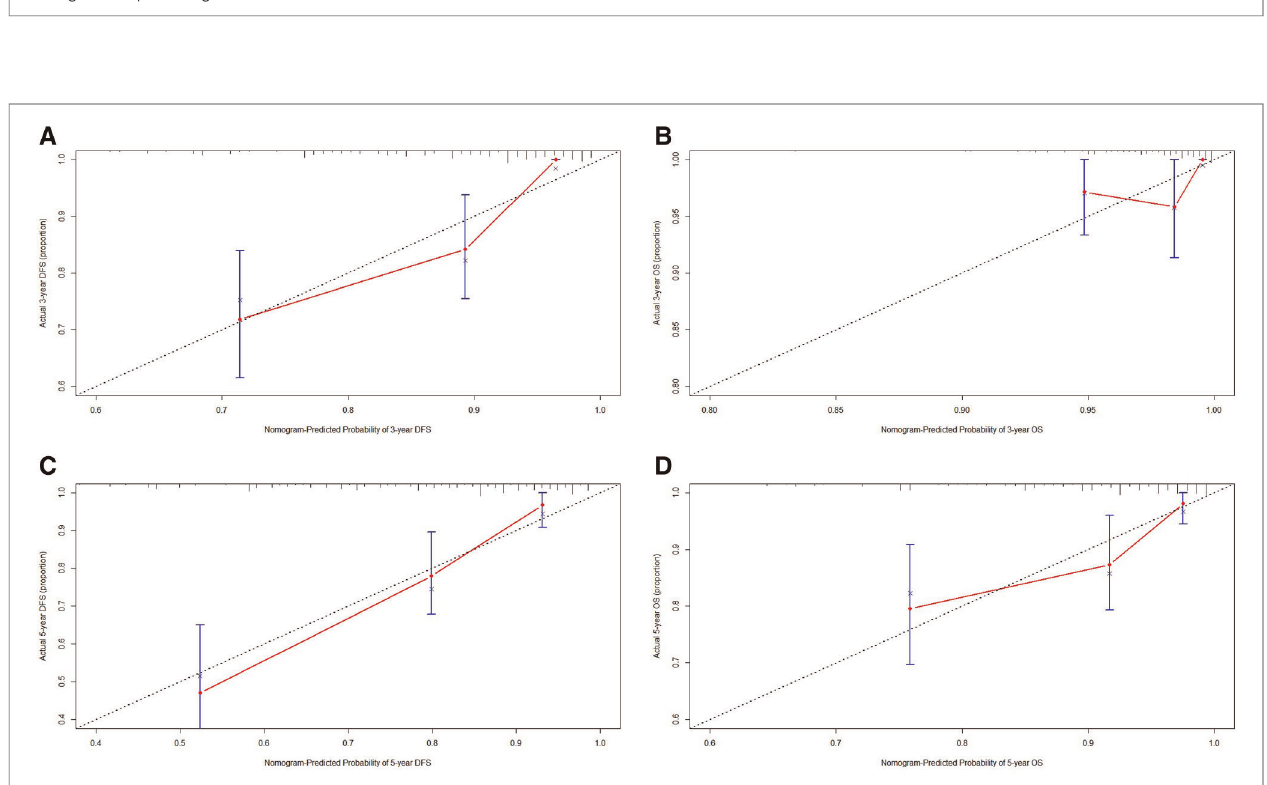
FIGURE 4 | The calibration curves for predicting the 3-, 5-year DFS and OS rates. ( A ) The calibration curves for predicting the 3-year DFS rate in patients with triple- negative breast cancer (TNBC); ( B ) The calibration curves for predicting the 3-year OS rate in patients with TNBC; ( C ) The calibration curves for predicting the 5-year DFS rate in patients with TNBC; ( D ) The calibration curves for predicting the 5-year OS rate in patients with TNBC.